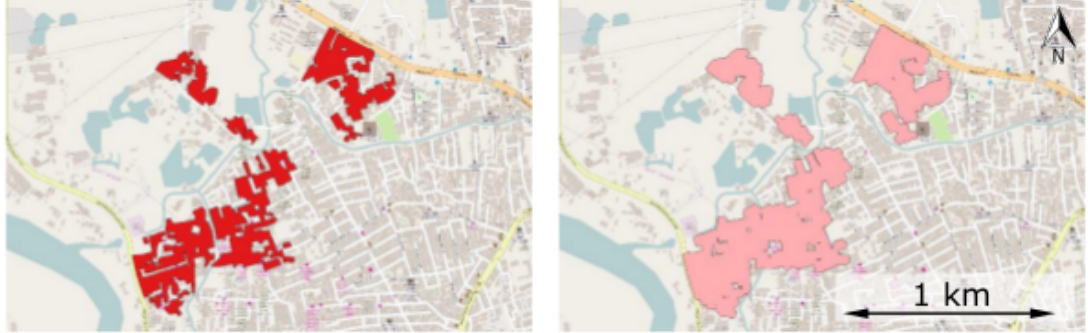
Figure 2. Slum cluster in Dhaka for 2010 with (right) and without (left) a buffer zone of 10 m, representing a lower spatial